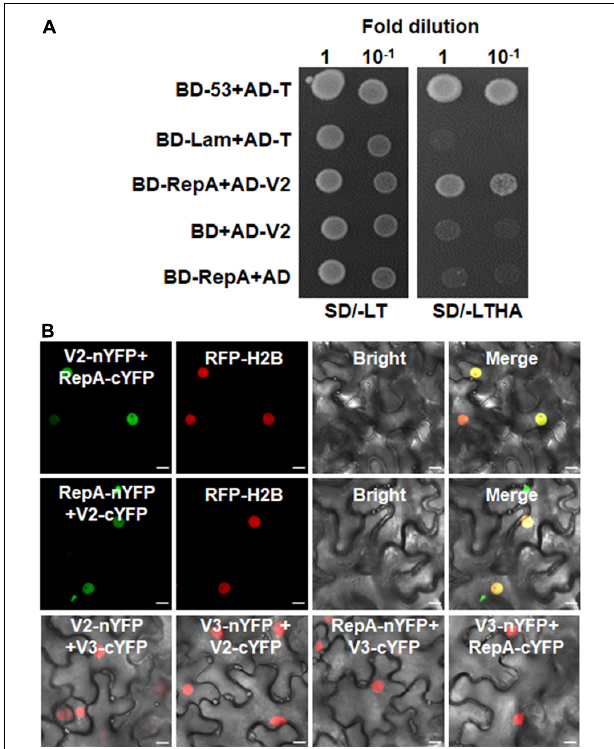
FIGURE 4 | RepA interacts with V2 in yeast and plant cells. (A) Yeast two-hybrid assay showing the interaction between RepA and V2 in yeast cells. Growth of yeast cotransformants containing the BD-RepA and AD-V2 fusions on the plates lacking leucine, tryptophan, histidine, and adenine (SD/-LTHA) indicates specific interaction between RepA and V2. (B) BiFC assay showing the interaction between RepA and V2 in plant cells. Combinations of BiFC constructs are shown at the top of each panel. Images were taken using a Zeiss LSM 880 confocal laser scanning microscope at 48 hpi. Reconstituted YFP signals as a consequence of V2-RepA interaction are depicted as a false-green color. RFP-H2B served as a nuclear marker.